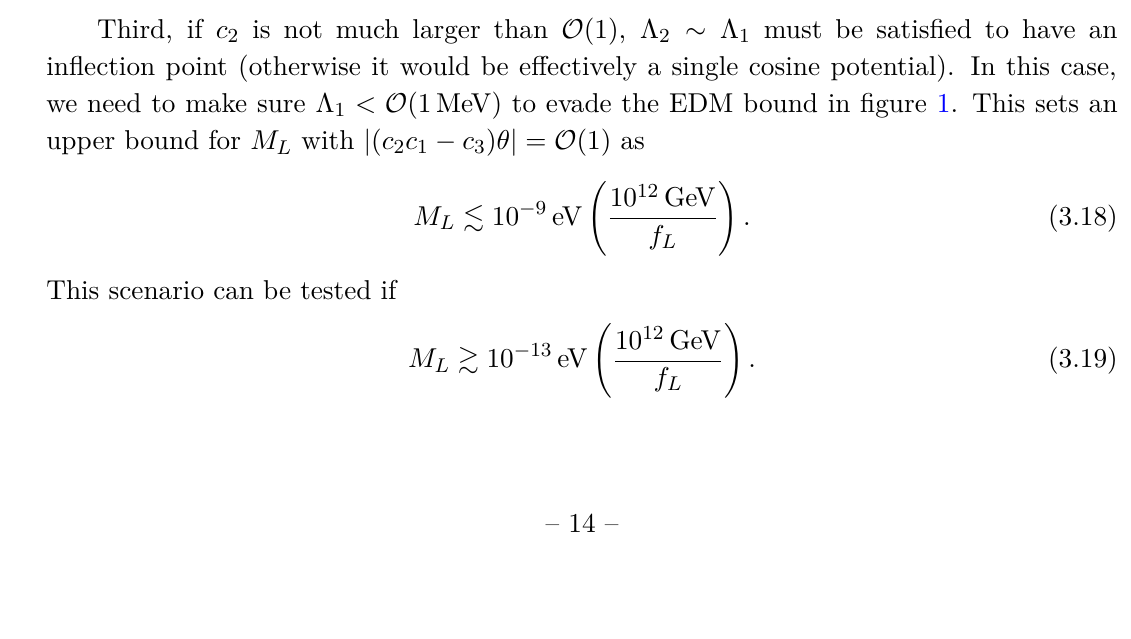
Figure 4 . The mechanism for abundant 1 Hz axion with f L . 10 16 GeV [upper panel]. During inflation, the axion is driven to the inflection point, φ ≈ φ ip , with H inf ∼ M L and N e < O (100) (Black dashed line). After inflation, the onset of oscillation is delayed due to the slow-roll with suppressed slope at around the inflection point (Red dashed line). The oscillation starts at H 2 ∼ | V 00 | (cid:28) M 2 . In the lower panel we show that the QCD axion starts to oscillate during inflation due L L to Λ 4 (cid:28) χ . The energy density is diluted due to the exponential expansion [Black dotted 1